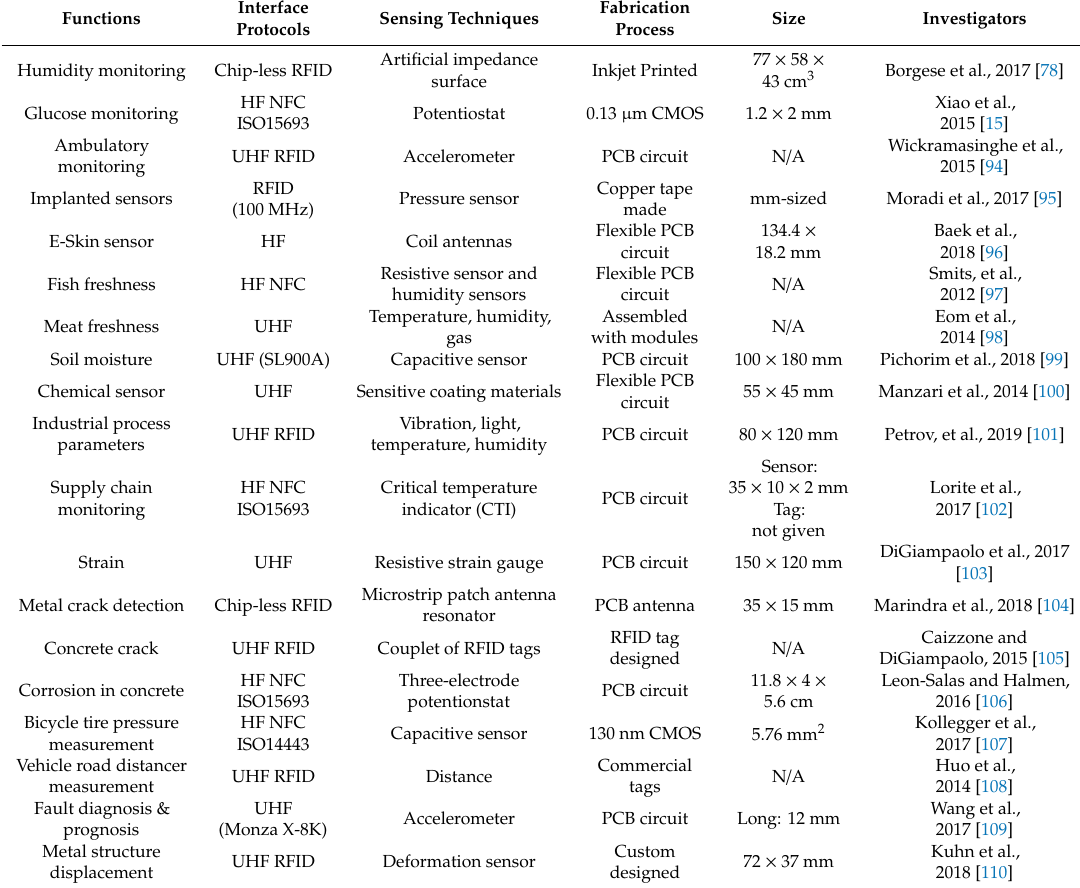
Table 3. Novel Applications of RFID